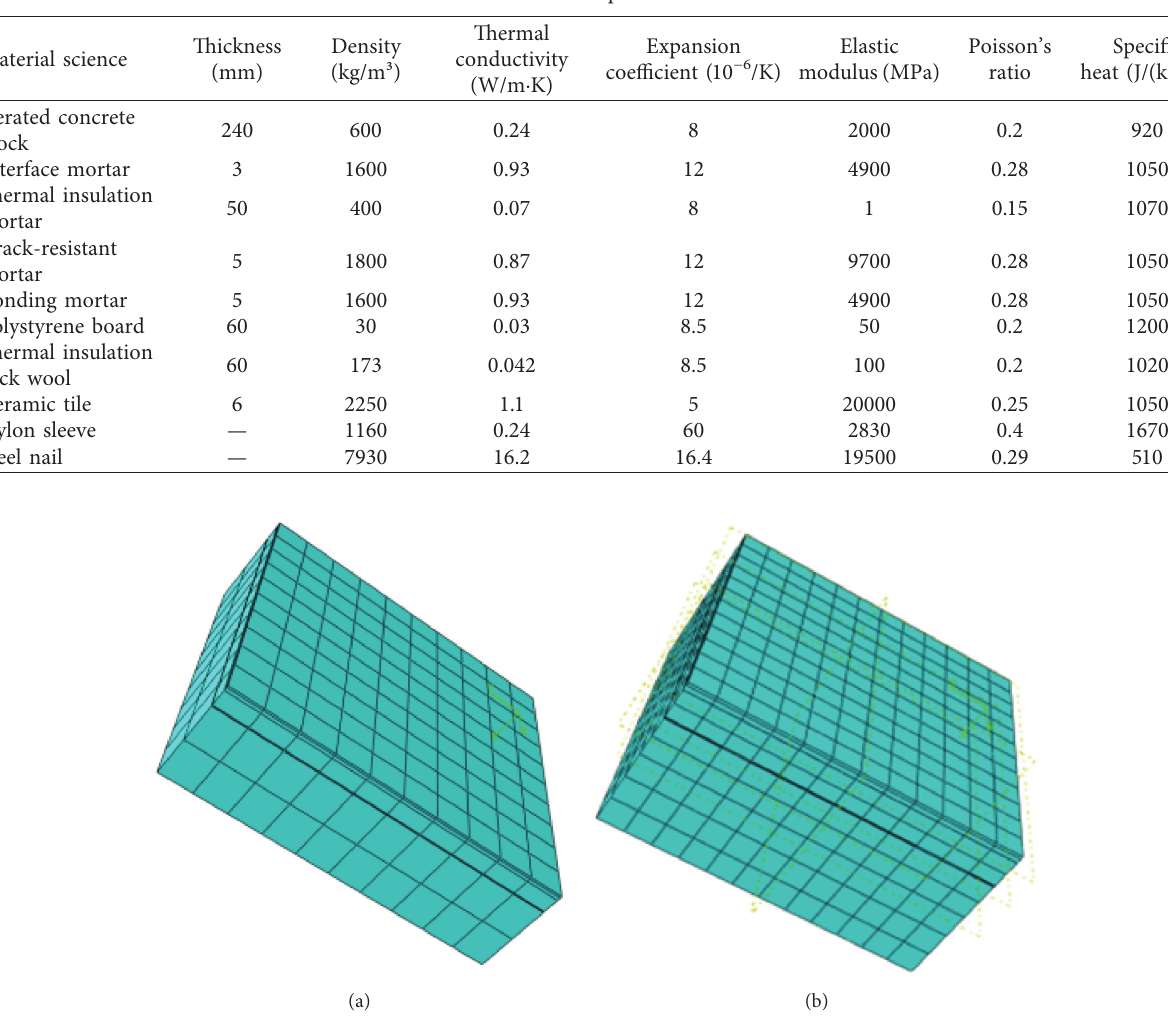
Figure 15: Model mesh generation. (a) Rigid finish layer. (b) Semirigid finish layer and flexible finish